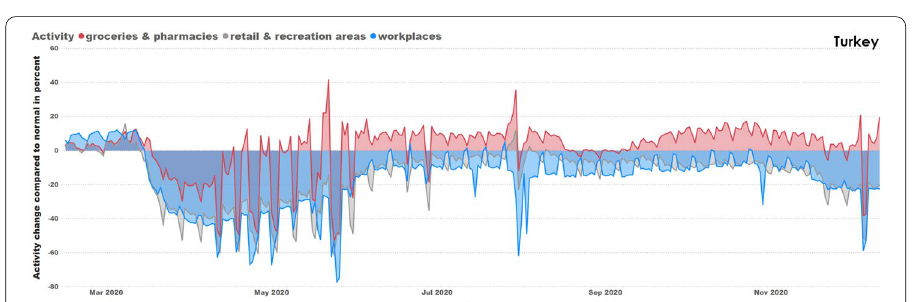
Fig. 18 Two main with additional short duration drop in activity